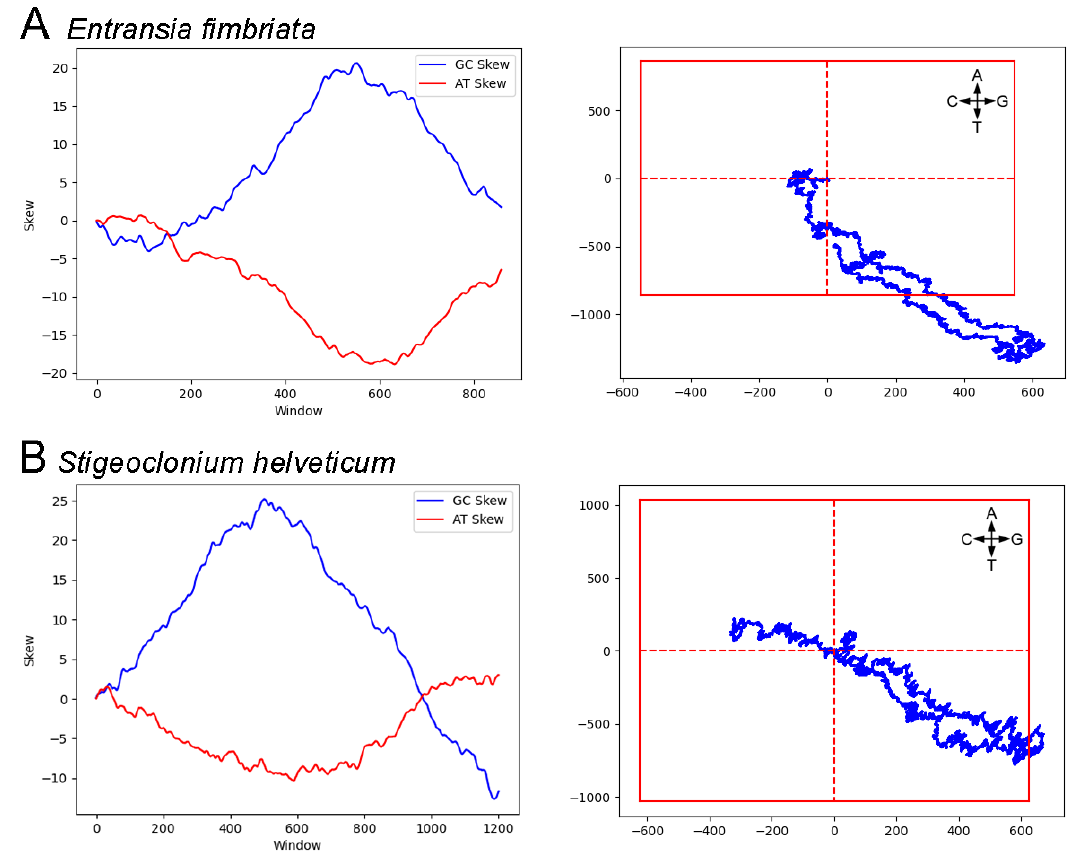
Figure 4. Cumulative skews and genome walk for the intergenic regions of the streptophyte Entransia fimbriata ( A ) and the chlorophyte Stigeoclonium helveticum ( B ). The skew was calculated using a window size of 1000 and an overlap of 100. For the genome walks, the direction of change for each base is indicated; the AT walk is on the vertical axis and the GC walk along the horizontal axis. The origin of each walk is the intersection of the dashed red lines and the outer box represents the significance point as described in the Section 2.